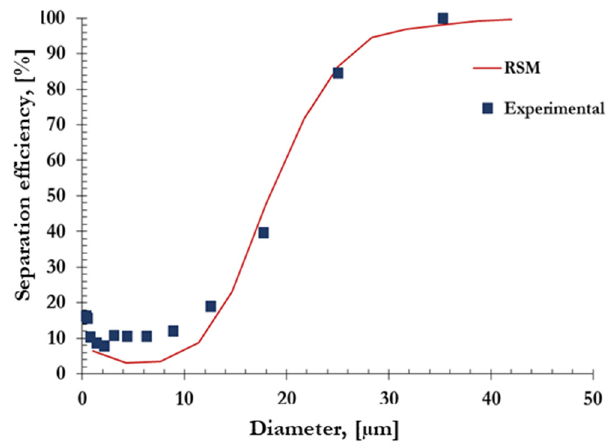
Figure 8. E ffi ciency separation Figure 8. Efficiency separation curve.